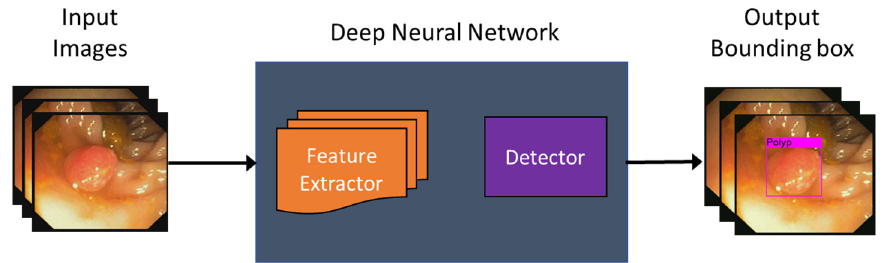
Figure 5. Automated polyp detection diagram using deep neural network. Pink box depicts the detected polyp that is the output of the automated detection model.